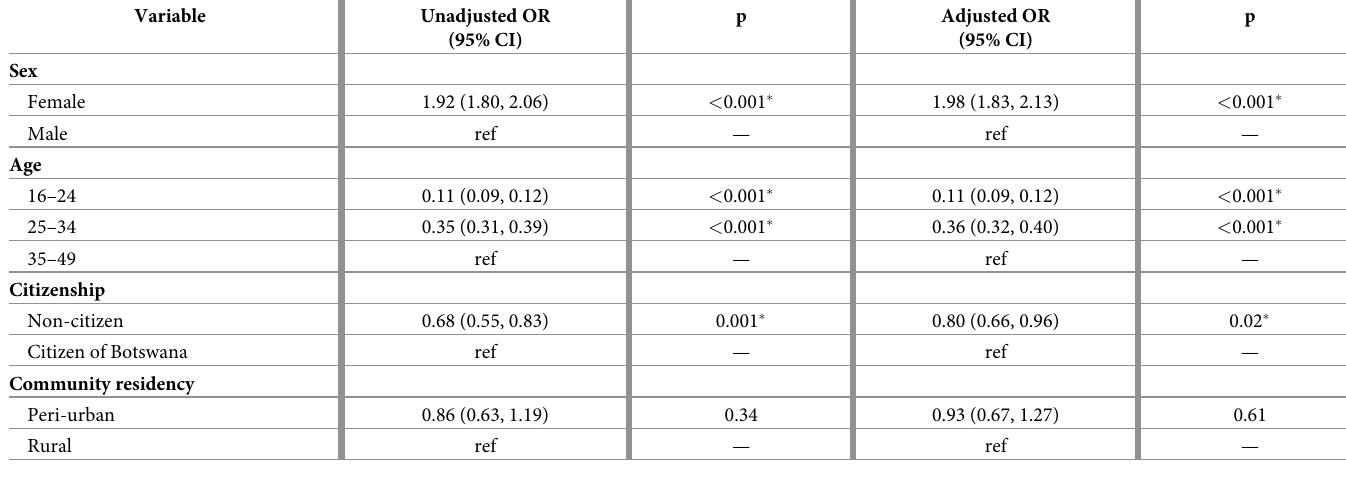
Table 3. Association of sociodemographic variables with HIV infection, n = 57,556.